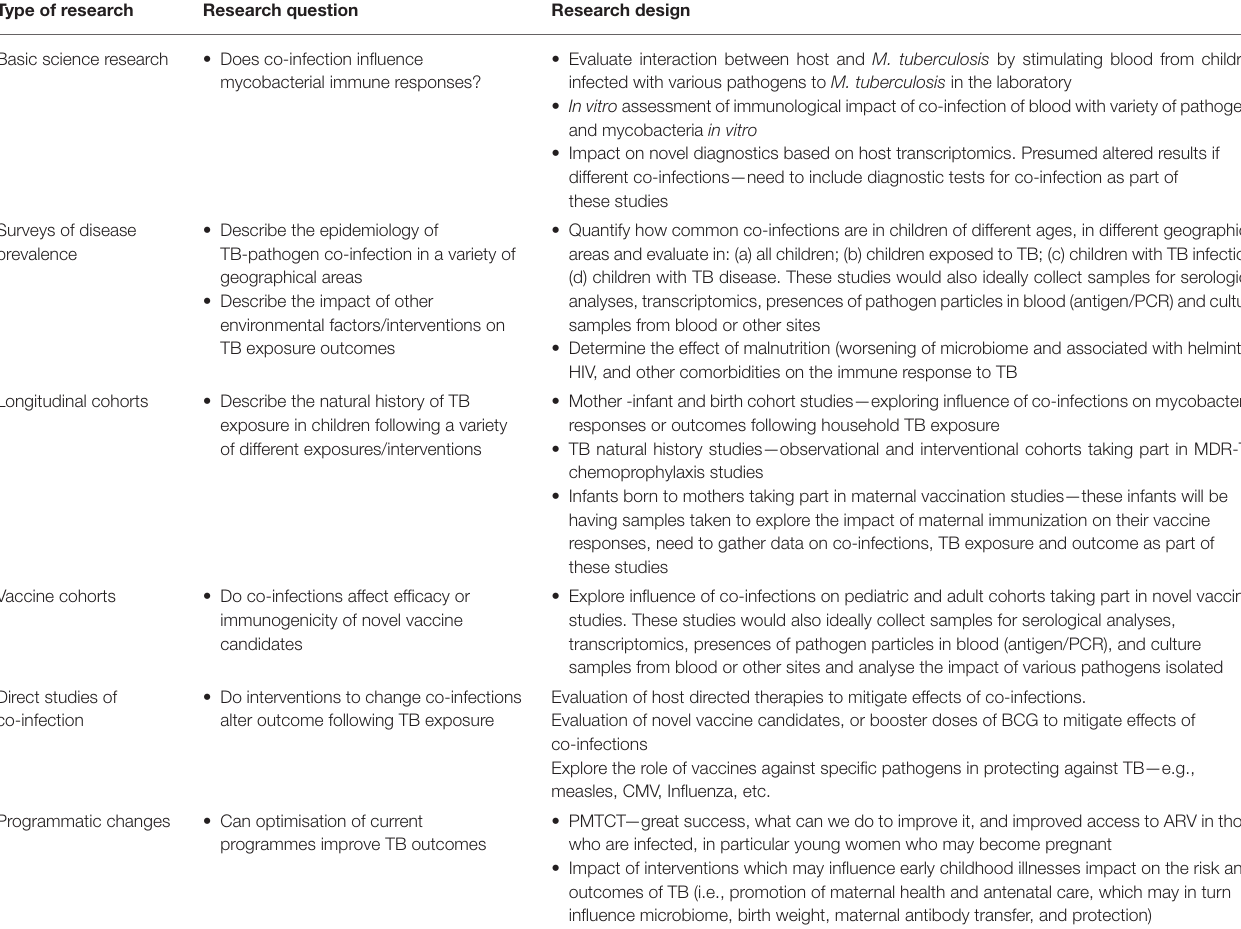
TABLE 3 | Potential study designs to answer the priority research questions in the field of tuberculosis